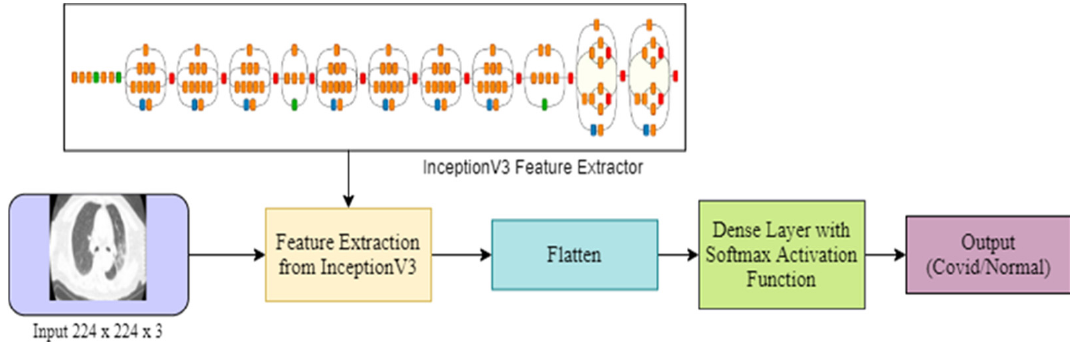
Figure 2. Transfer learning architecture based on Inception-v3.